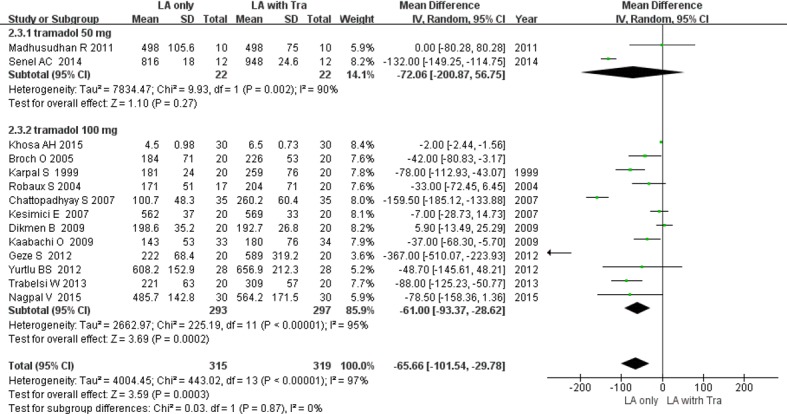
Forest plot demonstrating the duration of motor block.Subgroup analysis according to dose of tramadol. CI, confidence interval; LA, local anesthesia; SD, standard deviation; Tra, tramadol.